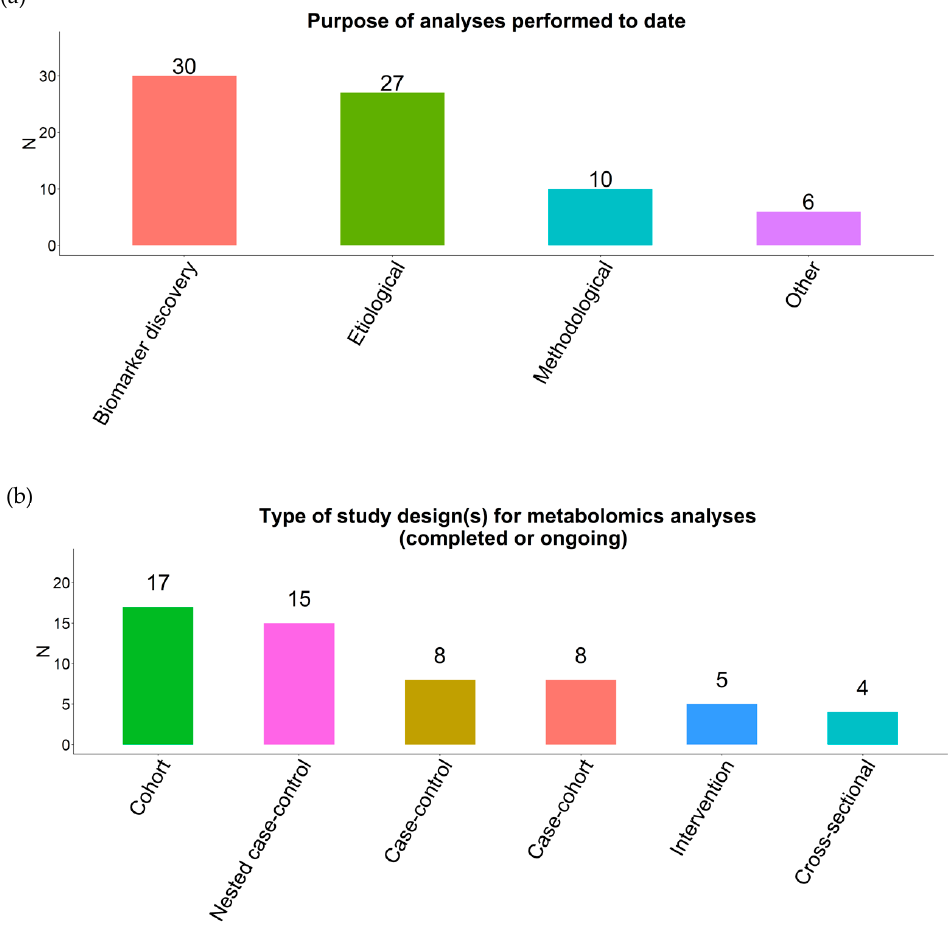
Figure 1. Description of study purpose ( a ) and study design ( b ) of participating Consortium of Metabolomics Studies (COMETS) cohorts.